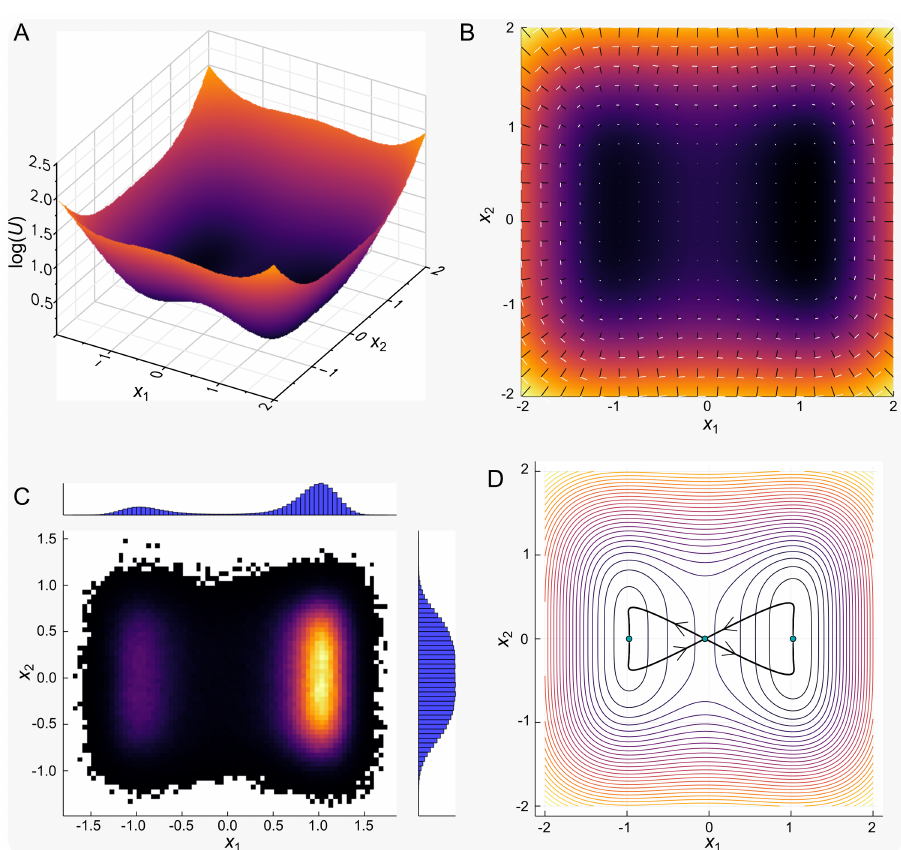
Fig 1. The two-dimensional SDE model. (A) surface plot of the potential field U ; (B) the vector field decomposed into the gradient (black) and curl (white) components; (C) the two-dimensional histogram generated from a long-run simulation of the system; (D) The minimum action paths (MAP) between stationary points X . On exit from an i attractor the MAP follows a path _ X ¼ r U þ f , before following a “free fall” path back towards a stationary point. U